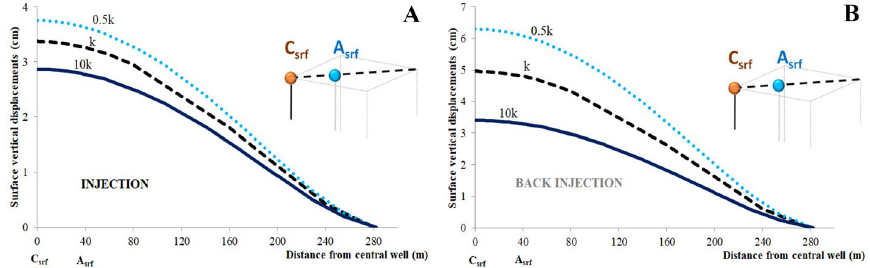
Fig. 22 Surface vertical displacements for different intrinsic permeabilities (0.5 k, k and 10 k) of the aquifer in the injection ( A ) and in the back injection ( B